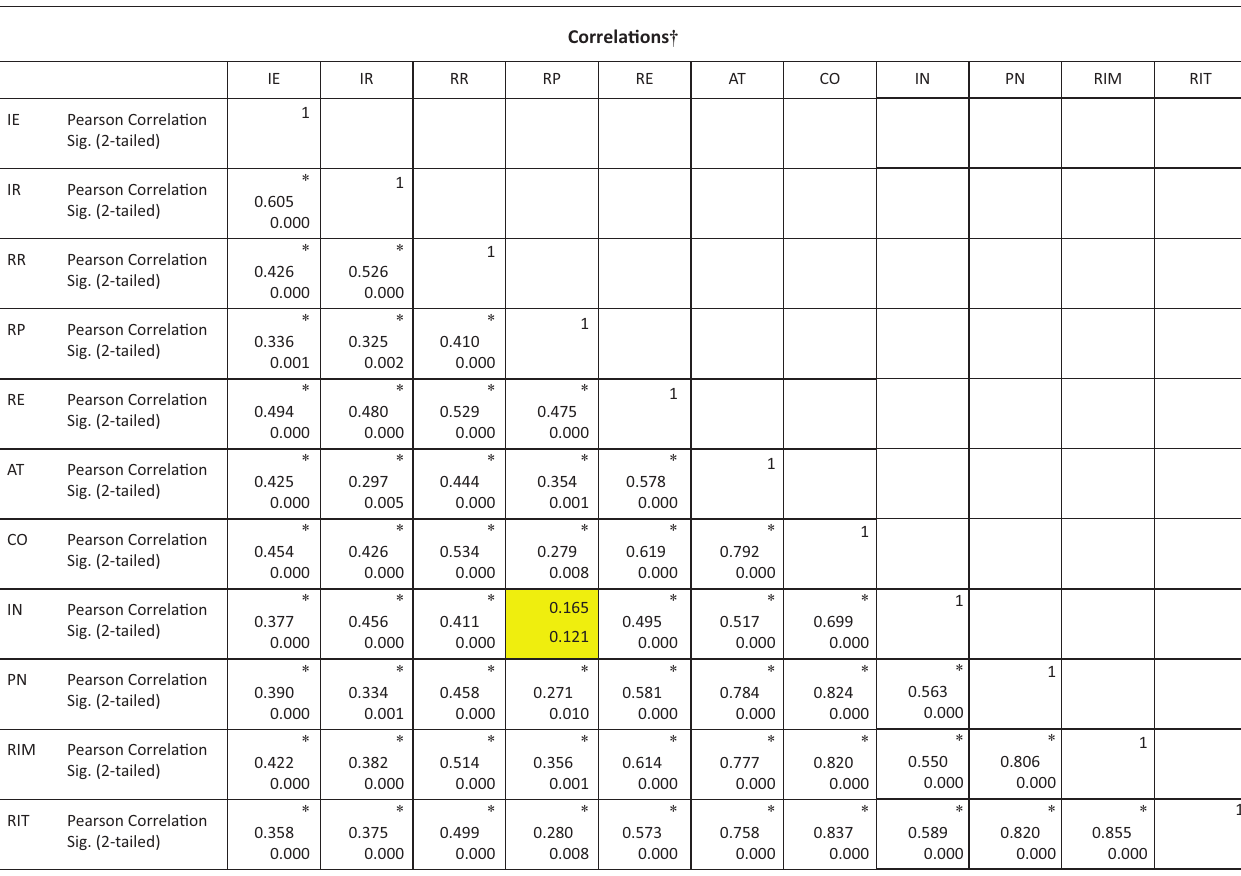
FIGURE 2: The correlation analysis